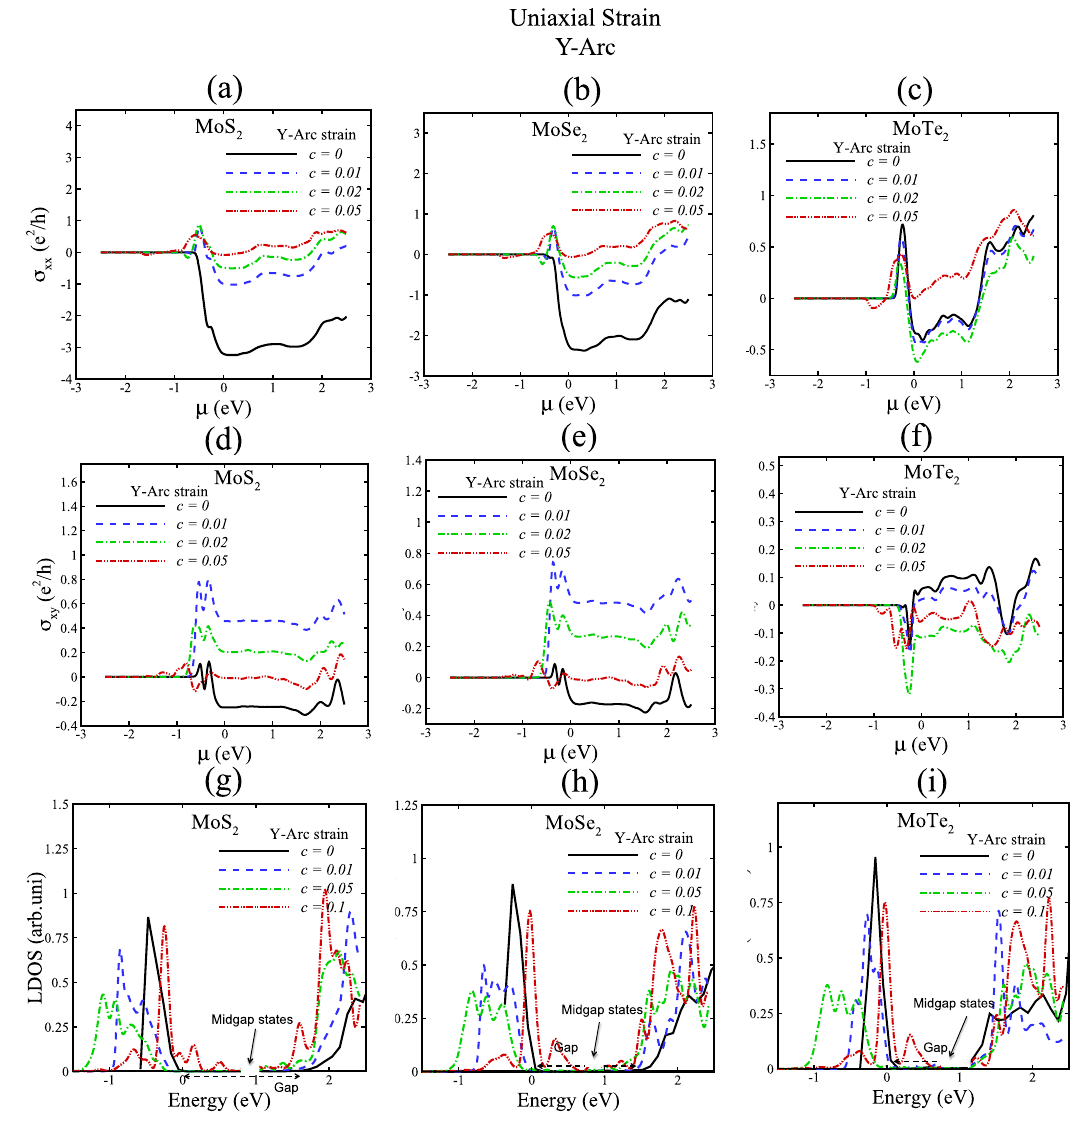
Figure 6. Hall conductivity and local density of states (LDOS) of MoX 2 (X = S, Se, Te) for uniaxial Y-arc strain with c = 0, 0.01, 0.02, 0.05, 0.1. In ( g ), ( h ) and (i ) gap and midgap states are